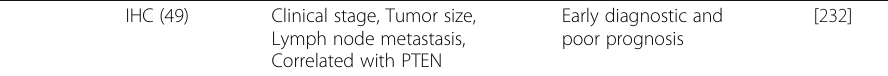
Table 1 Expression of survivin in SCCs. NC- no statistical correlation, IHC-immunohistochemistry, RT-PCR- reverse transcriptase, WB-western blotting